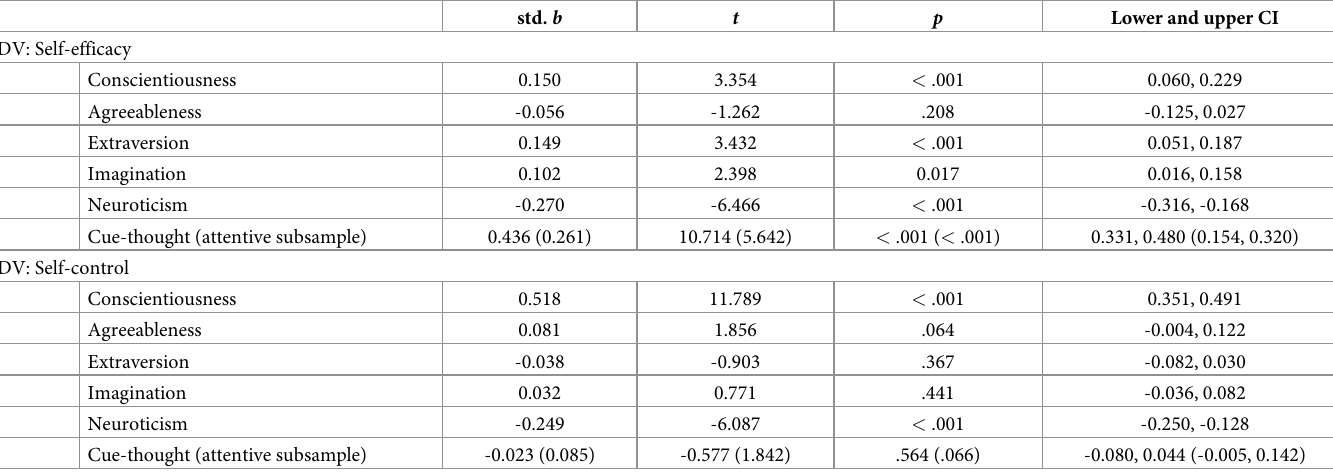
Table 3. Effects of cue-thought habits and Big 5 factors on self-efficacy and